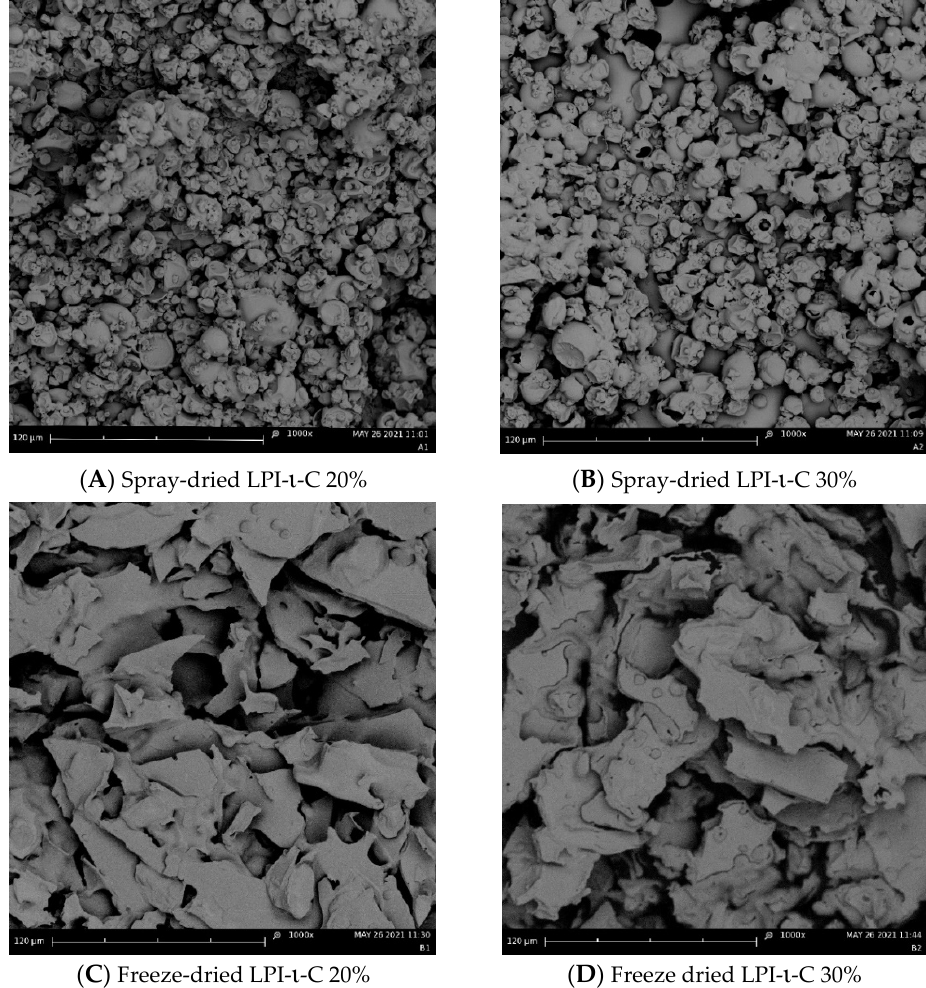
Figure 2. Scanning electron microscopy (SEM) images of the spray-dried LPI- ι -carrageenan (LPI- ι -C) 20% and 30% powders (( A , B ), respectively), and freeze-dried LPI- ι -C 20% and 30% powders (( C , D ), respectively) at 1000 × magnification. All the scale bars represent 120 µ